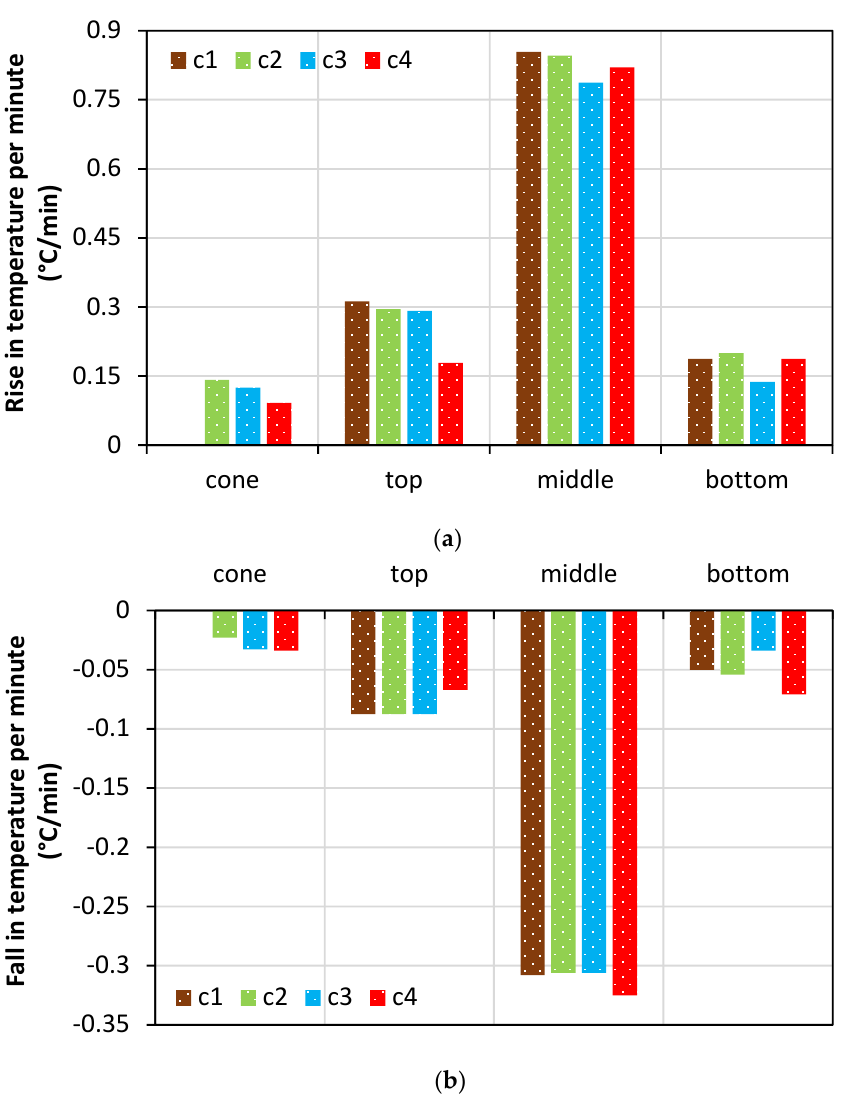
Figure 18. ( a ) The rate of temperature rise per minute under heating. ( b ) The rate of temperature fall per minute under the cooling phase.